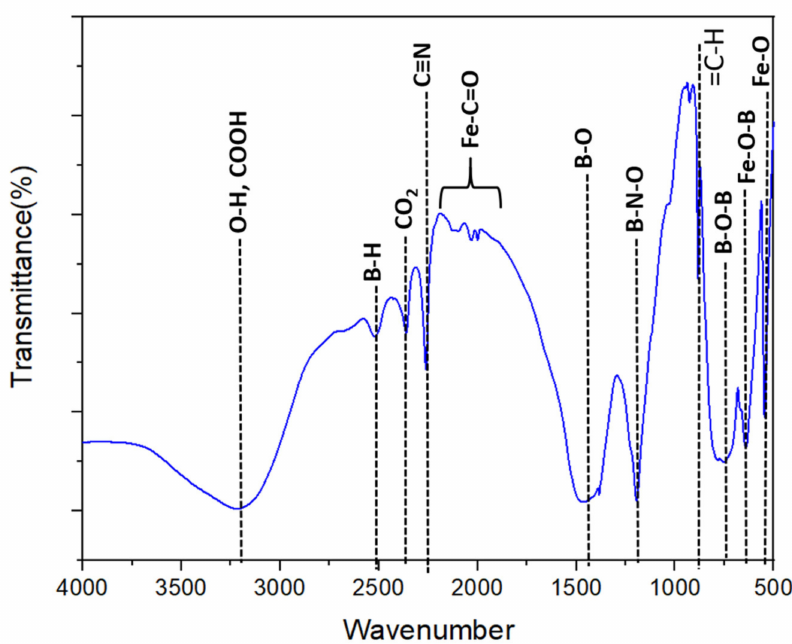
Figure 3. The FTIR spectrum of the as-prepared C,N-doped FeBO 3 .